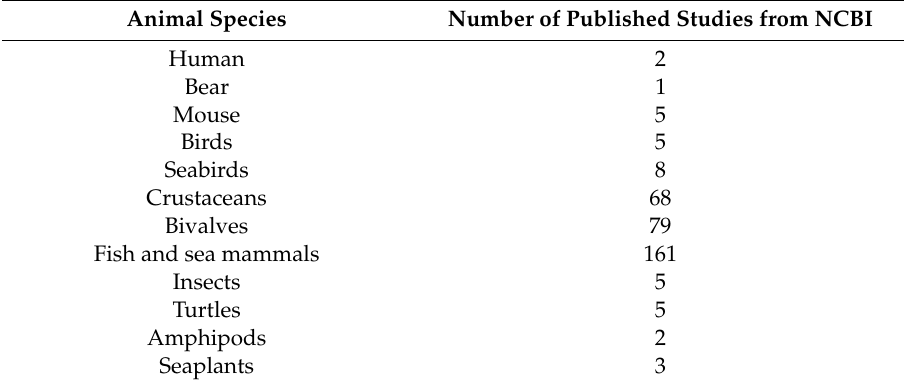
Table 1. Published studies from the National Center for Biotechnology Information (NCBI) on microplastic and / or nanoplastic contamination in di ff erent animal species. Animal Species Number of Published Studies from